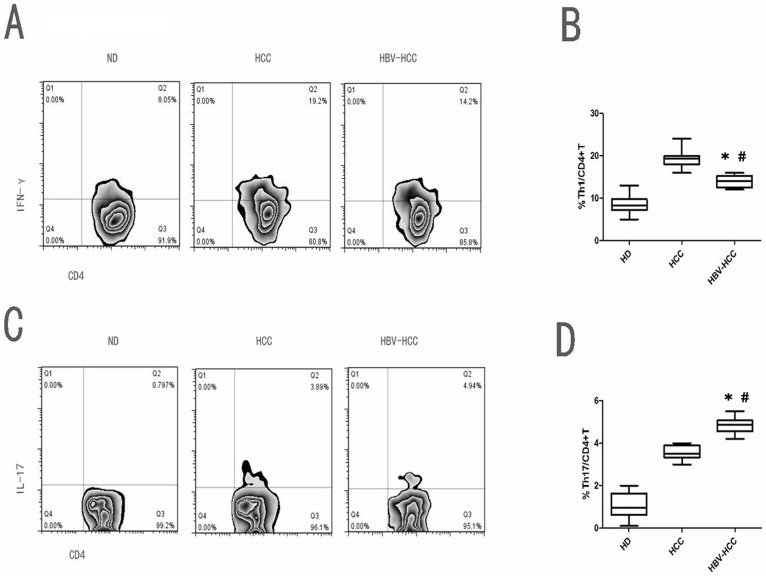
The frequencies of T cell subsets in peripheral blood from patients with HCC and healthy donors.(A, C) Representative flow cytometry data, and (B, D) statistical analyses compare baseline frequencies of circulating (A) IFN-γ-producing CD4+ T (Th1) cells and (C) IL-17-producing CD4+T (Th17) cells between patients with HBV-related HCC (HBV-HCC; n = 100), those with non- HBV-related HCC (HCC; n = 50), and healthy controls(ND; n = 50). Th17 cells and Th1 cells were both increased in patients with HCC compared to healthy controls. (B and D). Th17 cells were increased in HBV-related HCC more apparently than non- HBV-related HCC; conversely, Th1 cells were increased in non-HBV-related HCC more apparently than HBV-related HCC.